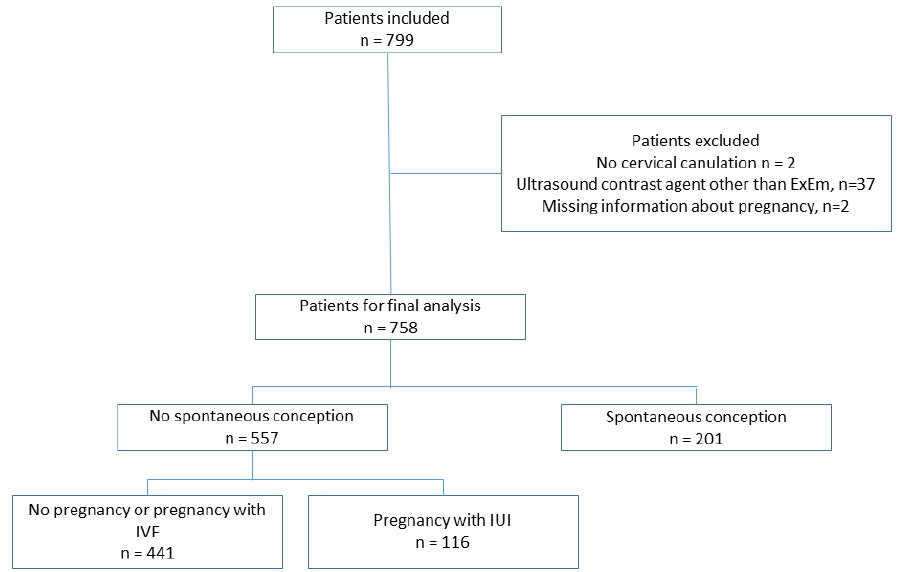
Figure 1. Flow-chart of patients included in the Figure 1. Flow ‐ chart of patients included in the study.